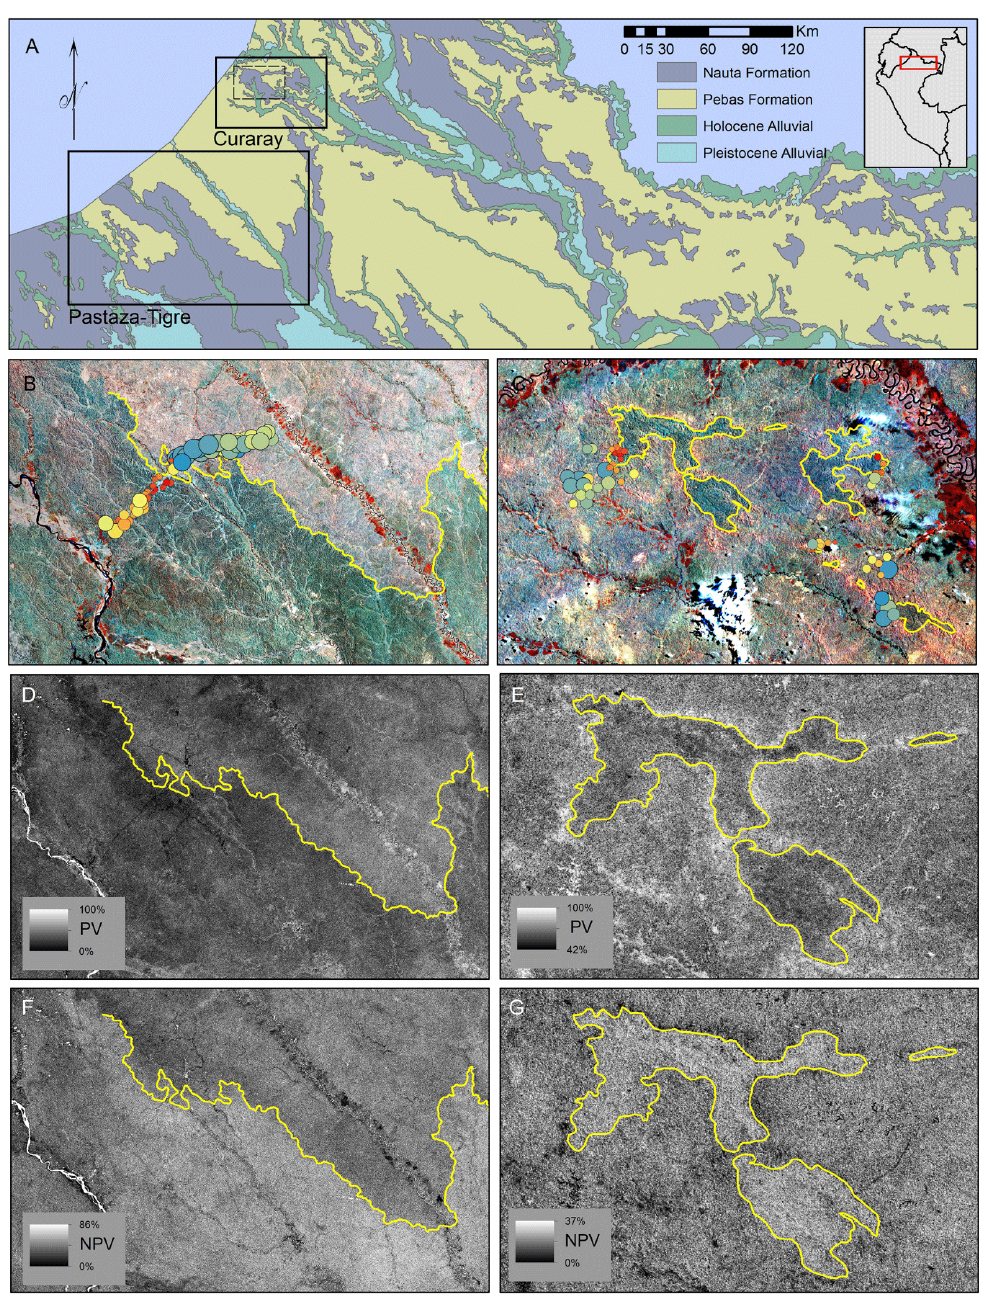
Figure 1. Patterns in geology, soils, plant species composition, and PV and NPV at sites in northern Peru. (A) Geological map for northern Peru (INGEMMET, 2000) with extents of maps in (B) to (G) indicated by solid and dashed lines. Red outline in gray inset indicates position of (A) relative to boundaries of Peru (center) and Ecuador (top left). (B) and (C) Nonmetric multidimensional scaling (NMDS) scores and the log-transformed sum of Ca, Mg, Na, and K concentrations (LSC) overlaid upon Landsat data for Pastaza–Tigre and Curaray study areas, respectively. Points indicate inventory sites and are sized by LSC values and colored by NMDS values, such that larger sizes indicate higher LSC values and blue tones indicate higher NMDS values. Landsat bands four, five and seven correspond to red, green, and blue. Yellow line indicates the boundary between the Pebas and Nauta formations; the Nauta Formation is to the west of the boundary in (B) and inside the boundary in (C) . The Pastaza River is located in the far west in (B) ; the Tigre River runs northwest to southeast through the center of (B) ; and the Curaray River runs from west to east in the north and east of (C) . (D) and (E) PV images for the Pastaza–Tigre and Curaray study areas generated from Landsat imagery for 8 September 2006 and 30 August 2000, respectively. Light tones indicate higher values and dark tones indicate lower values. Extent of (E) is indicated by dashed lines in (A) . (F) and (G) NPV images for Pastaza–Tigre and Curaray, as per (D) and (E)